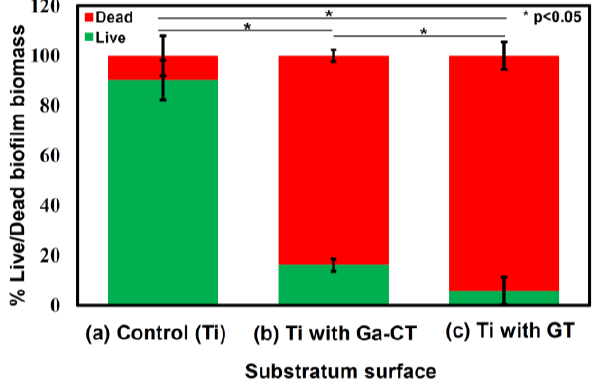
Figure 12. Live/Dead biofilm biomass on Ti surfaces contacted with multi-resistant Acinetobacter baumannii (MRAB12) for 7 days ( a ) as-polished; ( b ) subjected to NaOH-100Ca + 0.05Ga-heat-water or ( c ) NaOH-100Ga-heat-water treatment.